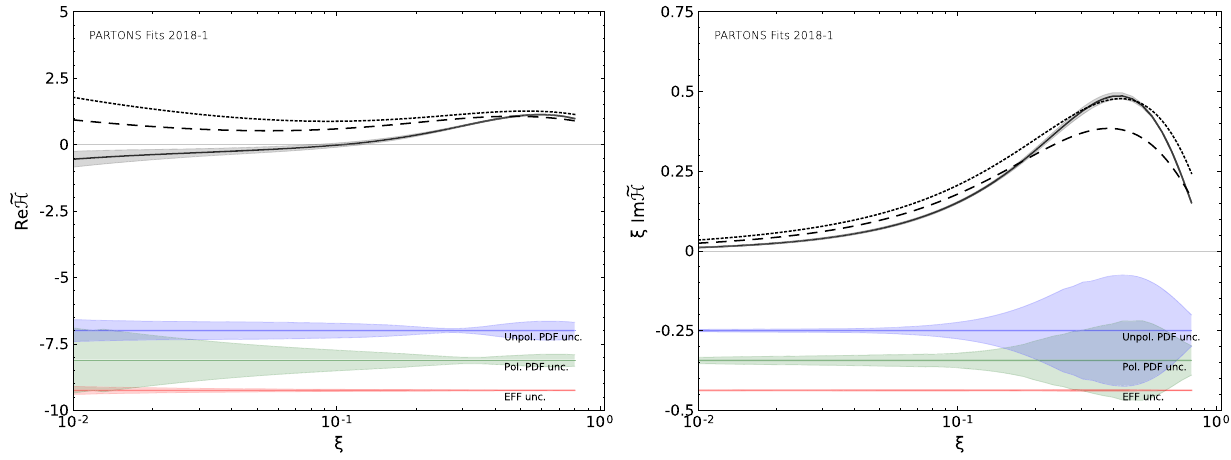
Fig. 12 Real (left) and imaginary (right) parts of the CFF (cid:8) H obtained in this work as a function of ξ at t = − 0 . 3 GeV 2 and Q 2 = 2 GeV 2 . For further description see Fig.